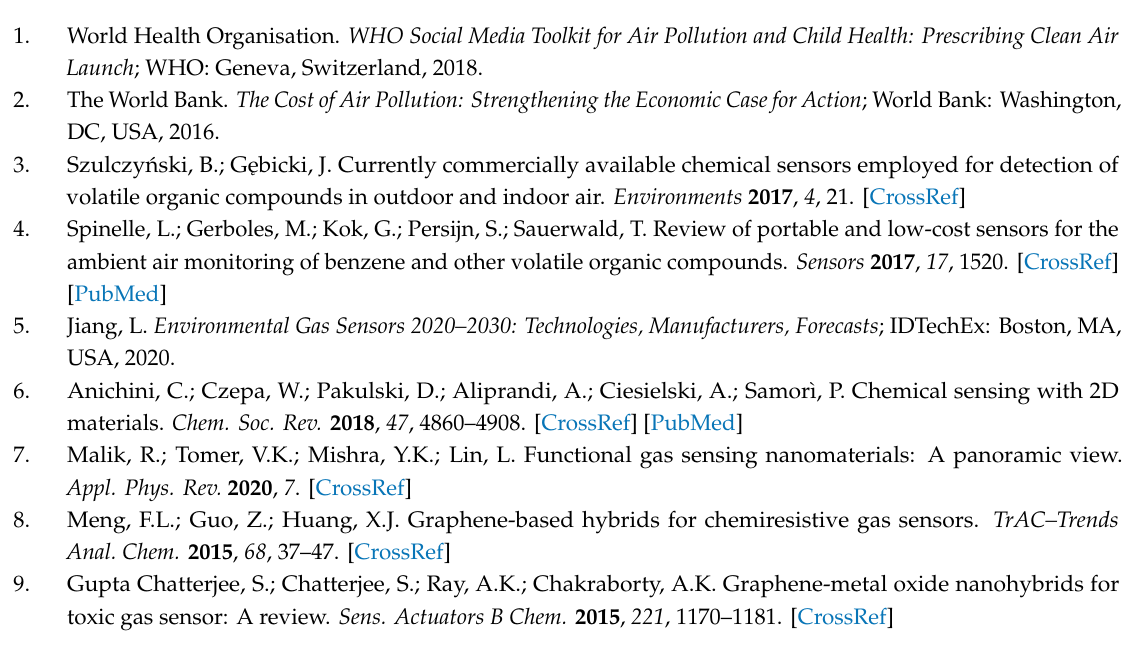
Table S1: Summary of changes of baseline resistance with varying relative